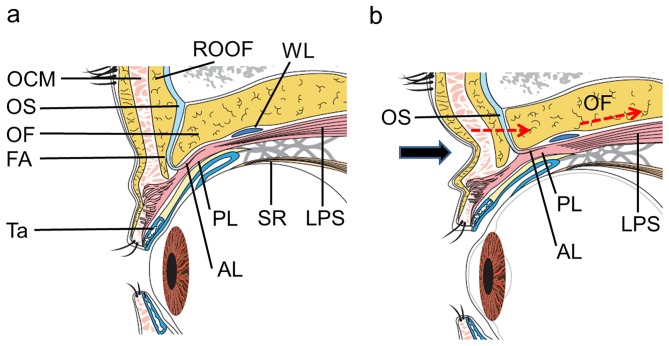
A schematic drawing of the upper eyelid and a possible mechanism underlying the presence of a DUES-like appearance.a. A schematic drawing of the upper eyelid associated with natural open eyes. b. A schematic drawing of the upper eyelid associated with wide-open eyes. A DUES-like appearance occurs when LA draws OS and fat toward the back of the eyeball. LPS: levator palpebrae superioris muscle, WL: Whitnall ligament, OF: orbital fat, OS: orbital septum, AL: anterior layer of LA, PL: posterior layer of LA, FA: fibroadipose layer, OCM: orbicularis oculi muscle, ROOF: retro-orbicularis oculi fat; SR: superior rectus muscle. The black arrow indicates the DUES-like appearance. The red dotted arrows show the effects of the LPS and LA.